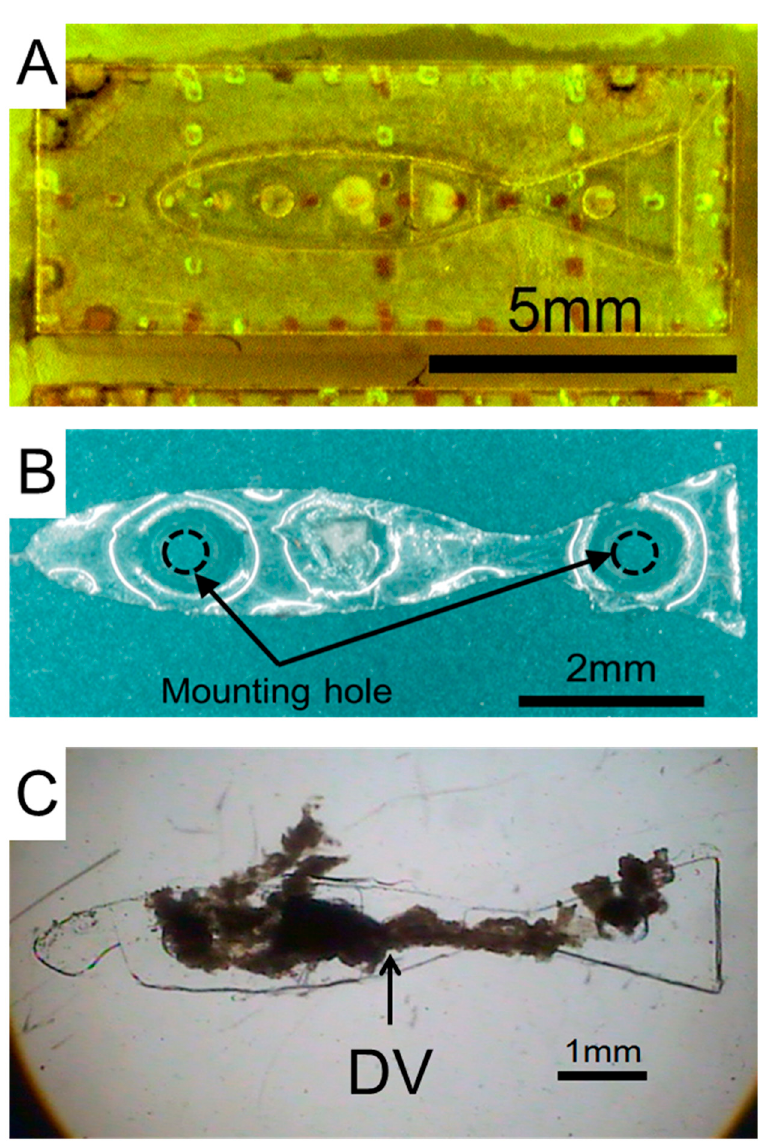
Figure 5. Photos of the products. ( A ) The mold fabricated by the stereolithography method. ( B ) The PDMS body of the robot after the baking process was carried out at 80 °C for 90 min. ( C ) The swimming robot with the attached DV.